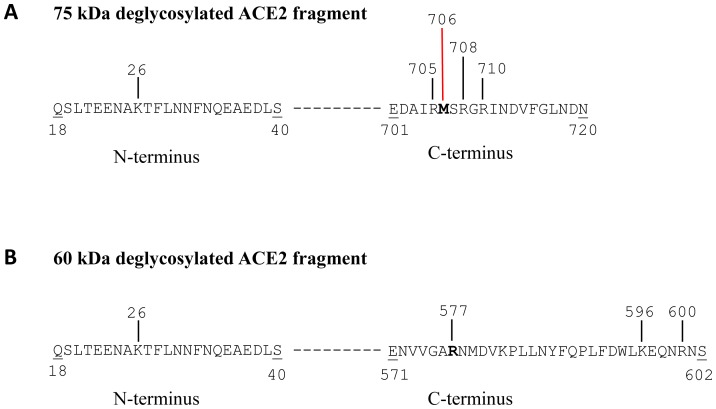
Diagram of 2 shed ACE2 fragments and putative C-terminal cleavage sites determined by LC-MS/MS.A) Partial amino acid sequence of 75 kDa shed ACE2 fragment (deglycosylated) is shown, beginning with N-terminal amino acid Gln18 (Q). The first and last amino acids of the C-terminal and N-terminal fragments are underlined, where numbers below the line indicate their amino acid positions. The dashed line represents amino acids between position 40 and 701 (sequence not shown). The most C-terminal amino acid observed is shown in bold. Vertical black bars represent sites of tryptic cleavage. Red vertical bar is non-tryptic cleavage site at Met706 (M), a putative ACE2 cleavage site. B) Partial amino acid sequence of 60 kDa shed ACE2 fragment (deglycosylated) is shown, beginning with N-terminal amino acid Gln18 (Q). The first and last amino acids of the C-terminal and N-terminal fragments are underlined, where numbers below the line indicate their amino acid positions. The dashed line represents amino acids between position 40 and 571 (sequence not shown). The most C-terminal amino acid observed is shown in bold. Vertical black bars indicate sites of tryptic cleavage, and include Arg577 (R) and Lys596 (K). Cleavage site for this fragment may occur at or C-terminal to Arg577.